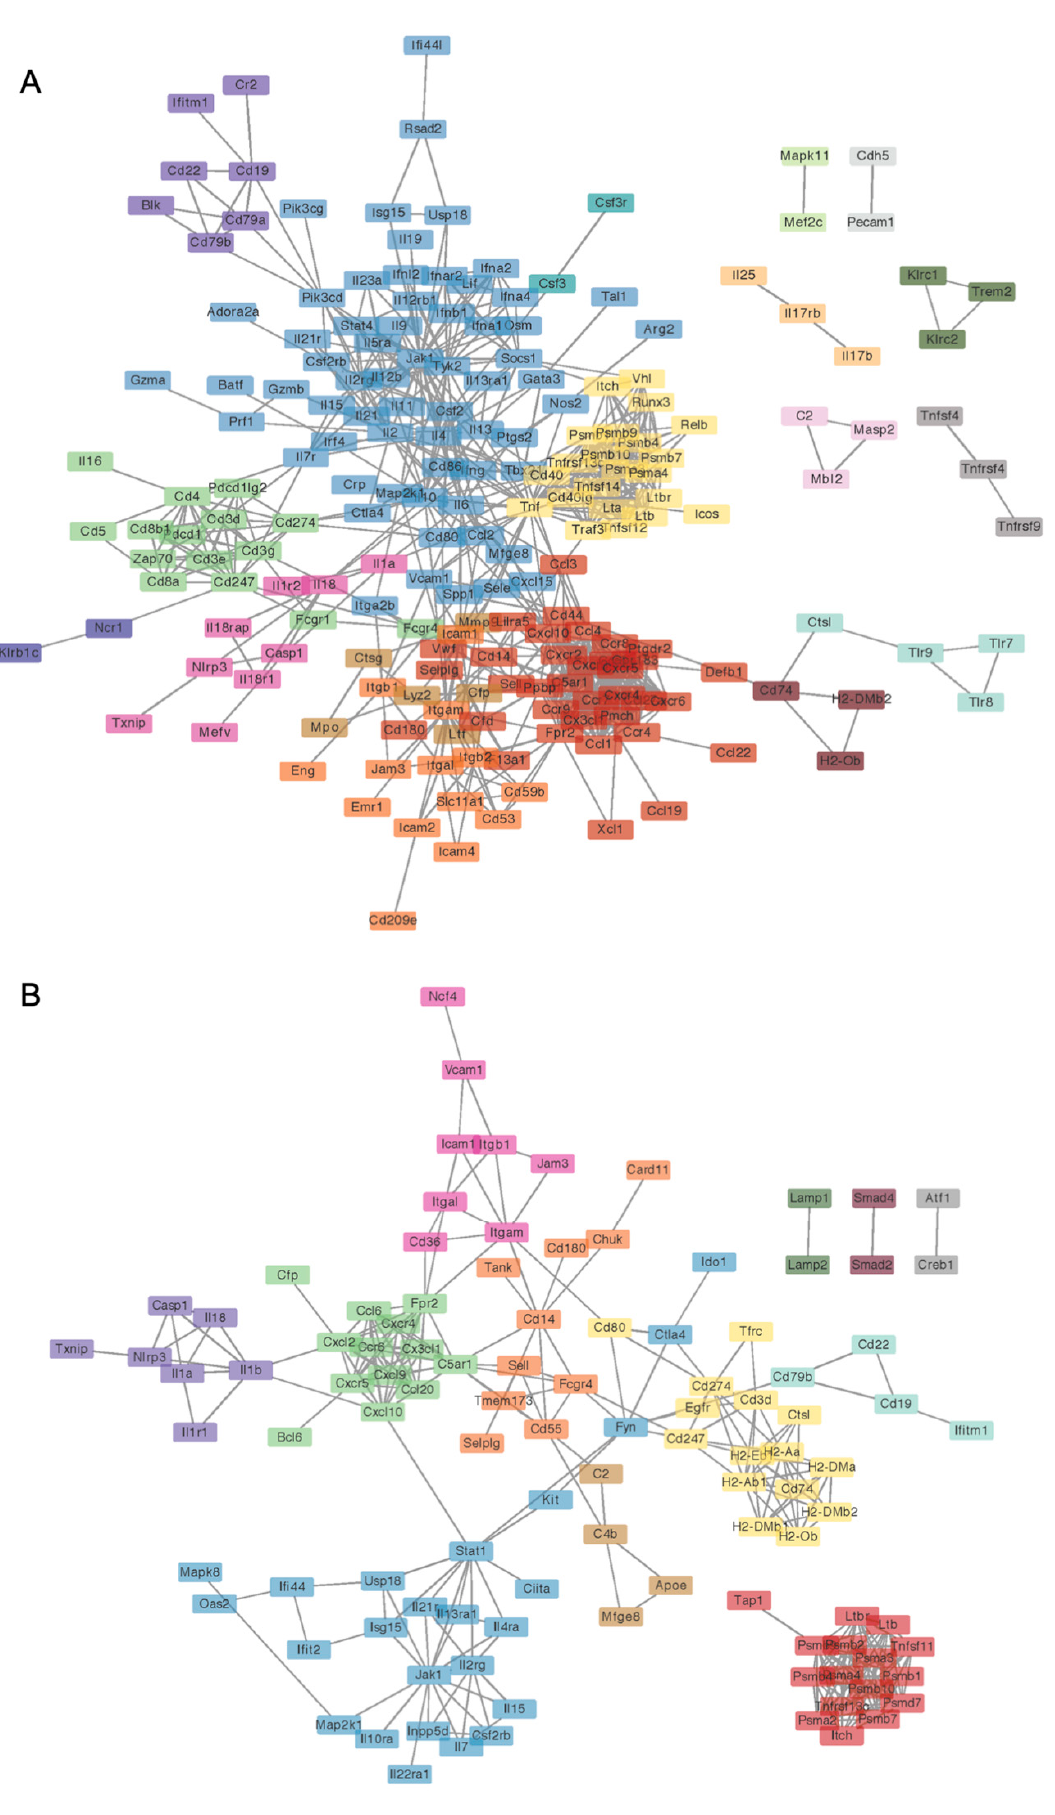
Figure 9. (prior page) Network visualization of significant di ff erentially expressed immune